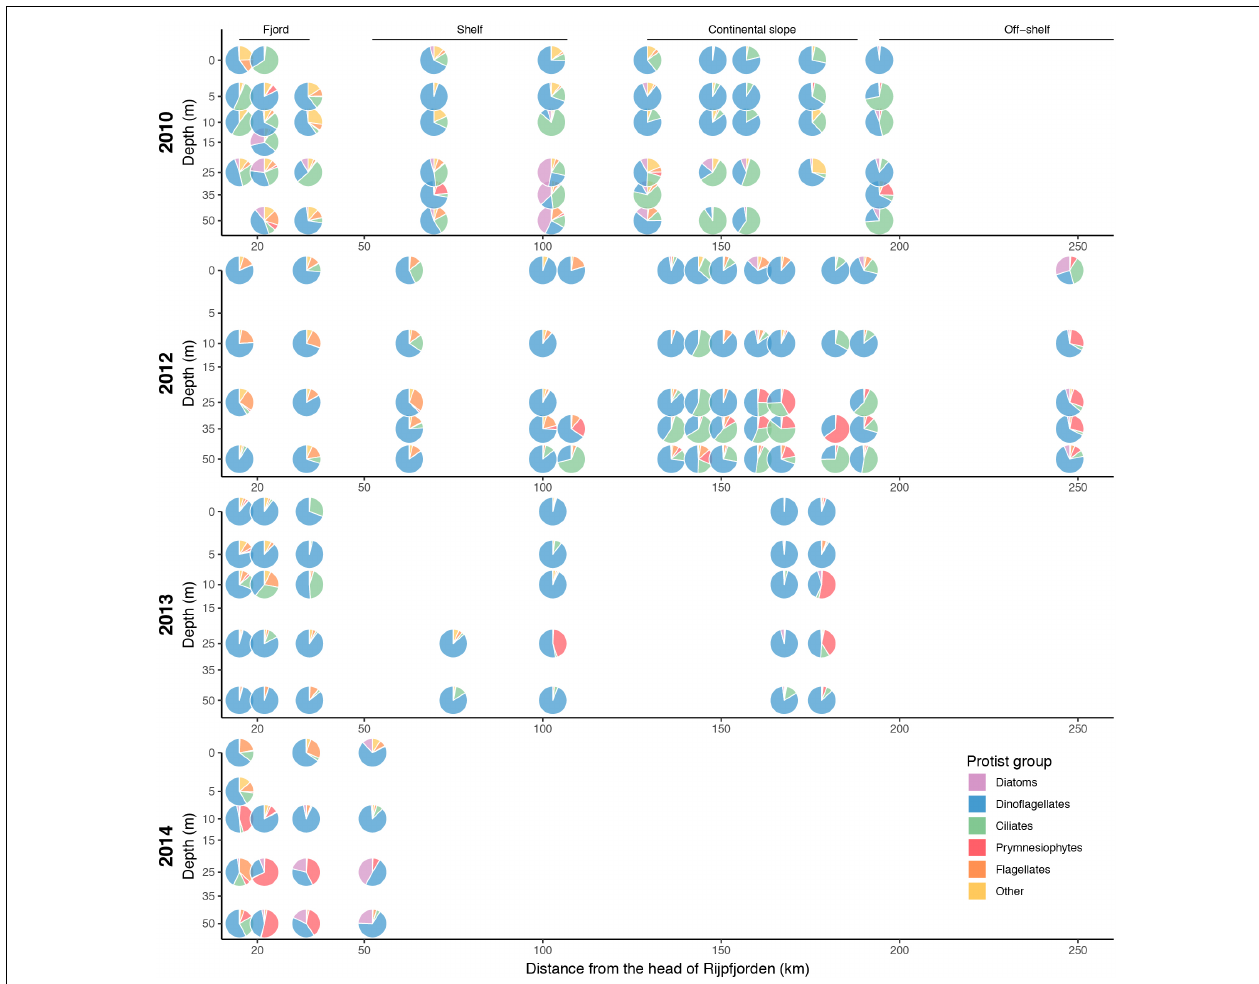
FIGURE 7 | Average contribution of major protists groups to total protist biomass ( µ g C L − 1 ) along the transect from Rijpfjorden to the Arctic Ocean for 2010, 2012, 2013, and 2014. Samples have been binned vertically to [0, 5], [5, 10], [10, 15], [15, 30], [30, 40], and [40, 50] m depth